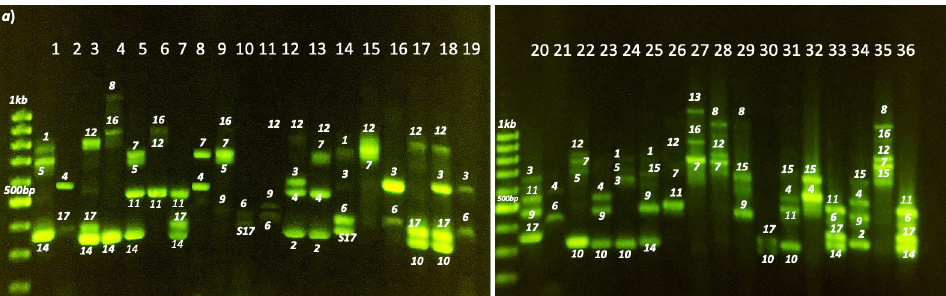
Fig 2. PCR amplification of 36 dried prune cultivars and selections, obtained with the primers PruC2-PCER. Assessment of the alleles was accomplished after individual band isolation, cloning and sequencing.